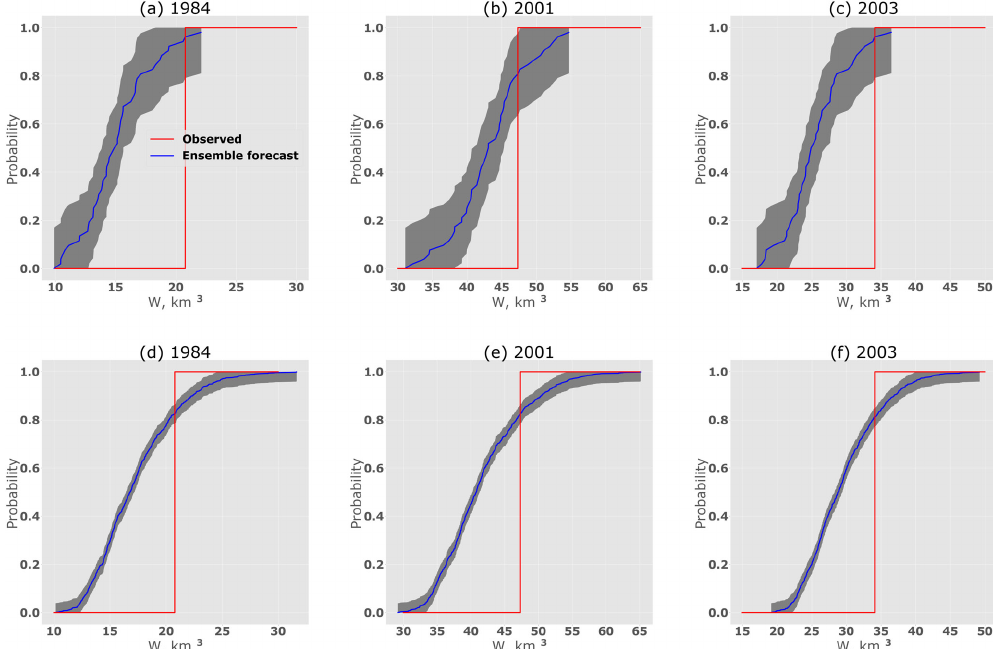
Figure 11. Cumulative probability distribution functions for W in April–June for selected years between 1982 and 2016 for the ESP-based forecast (a–c) and the WG-based forecast (d–f) . The shaded area presents the interval of 95% confidence probability.